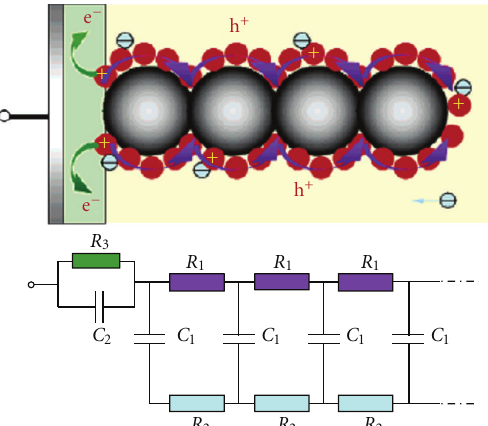
Figure 12: Schematic model showing the cross-surface charge percolation through the molecular monolayer adsorbed on mesoscopic oxide films (taken from